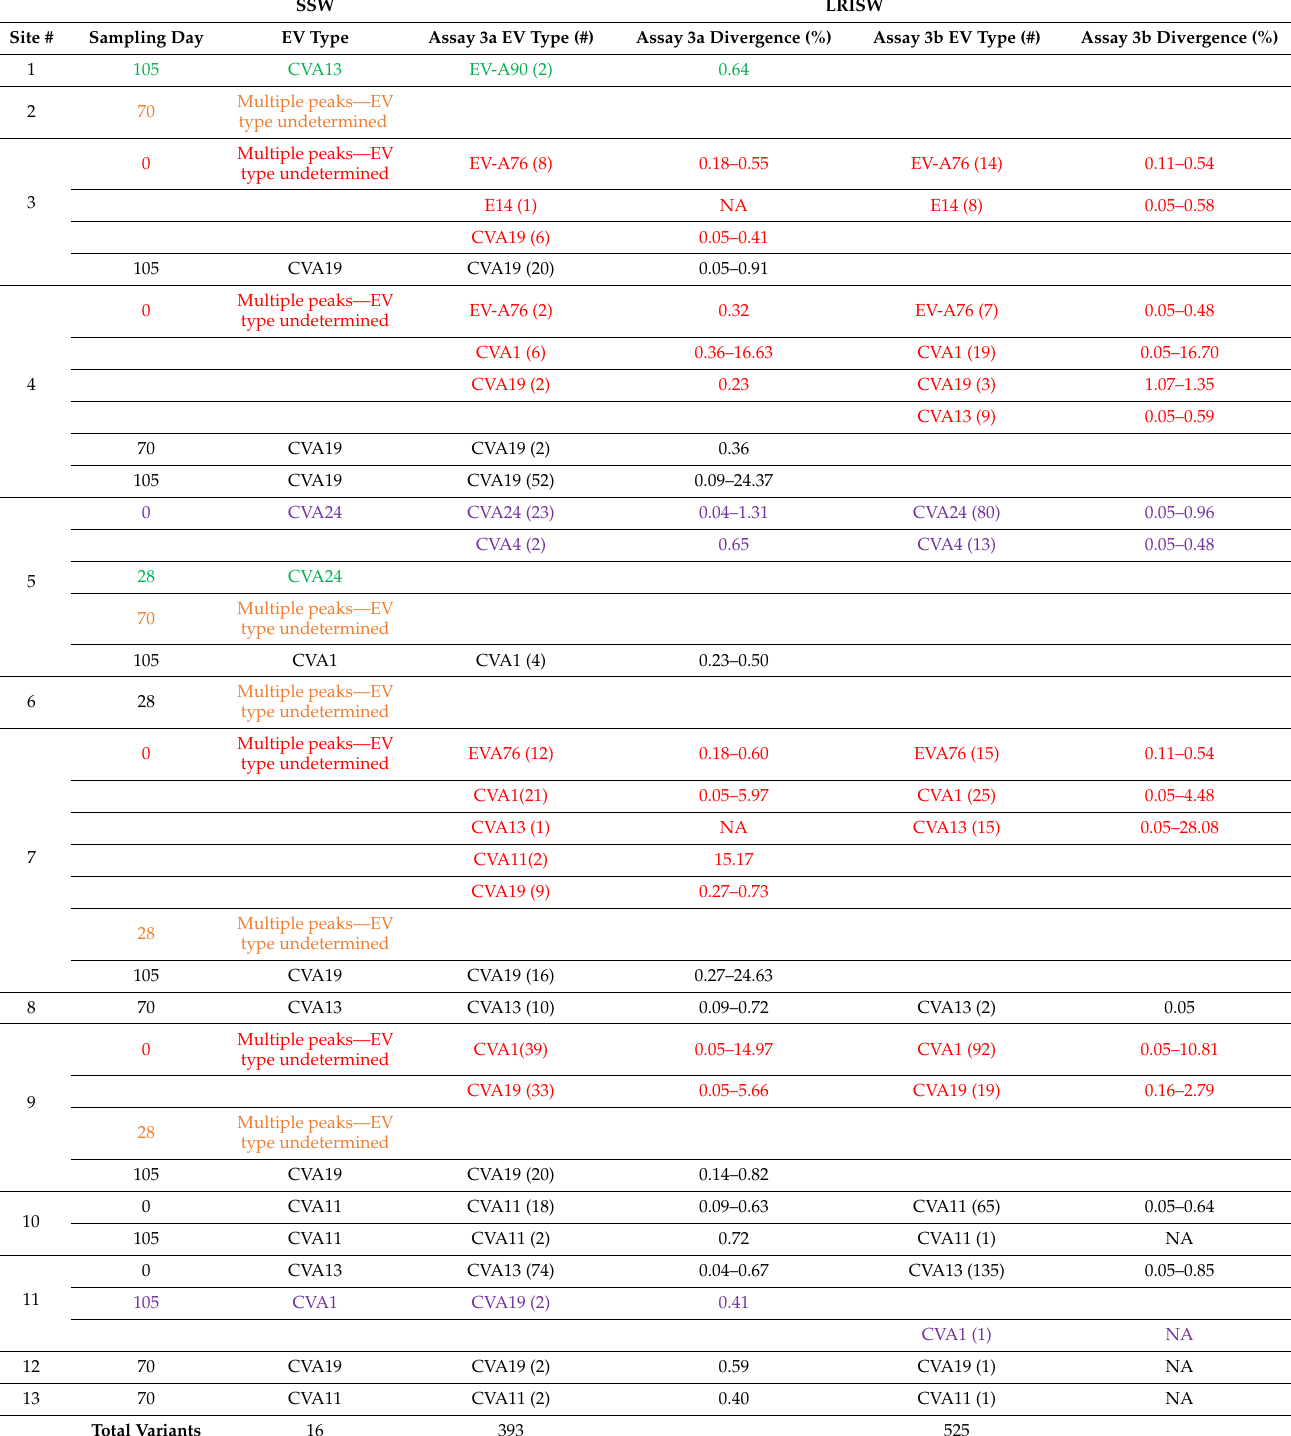
Table 2. Details of EV types recovered using the Sanger and LRI